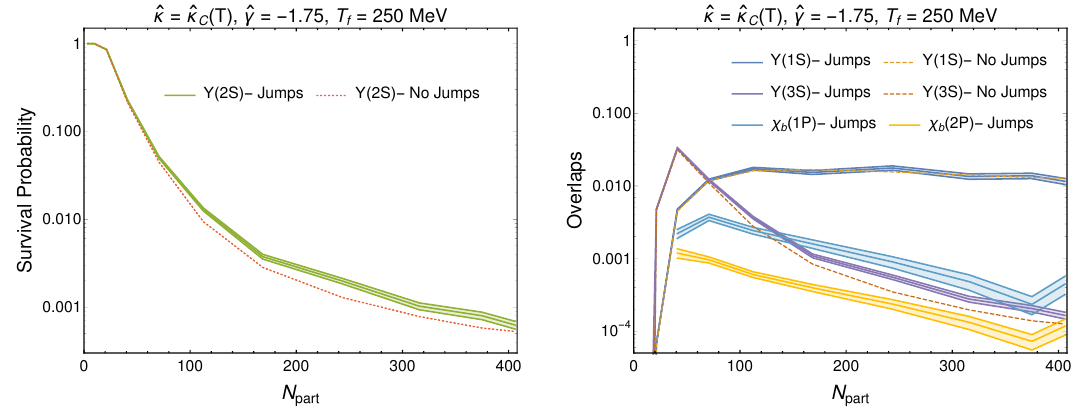
Figure 17 . Survival probabilities/overlaps versus N part with an Υ(2 S ) initial condition. Styling is the same as figure 16.